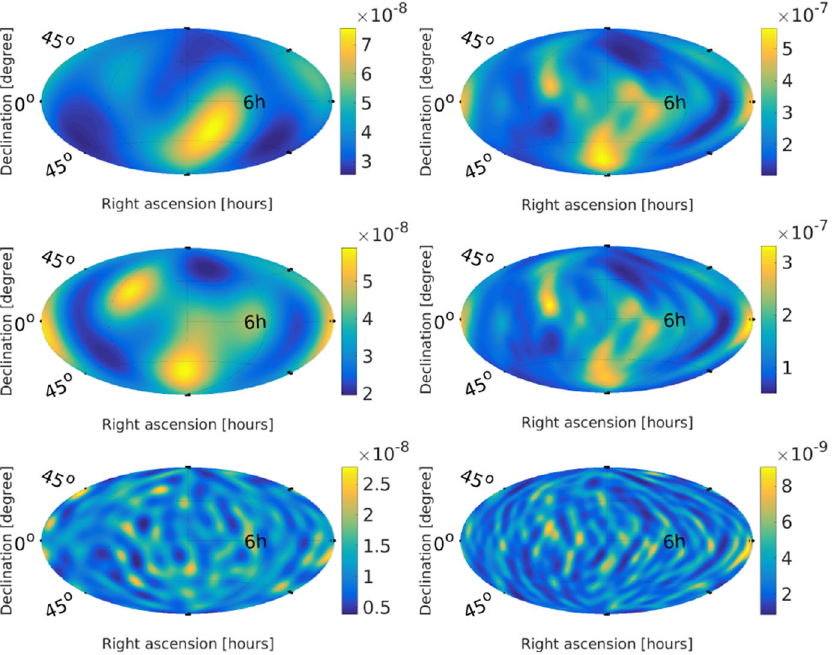
Fig. 85 90% confidence-level upper-limit maps on gravitational-wave power for anisotropic backgrounds having spectral indices β = 0, 2/3, and 3 ( first, second, and third row , respectively). The data analyzed were from advanced LIGO’s first observational run O1 (Abbott et al. 2016a). Left column UL maps on the fractional energy density Ω β ( ˆ n ) expressed in units of sr − 1 , constructed using the spherical harmonic decompositionmethodoutto l max = 3,4,and16. Rightcolumn ULmapsontheenergyflux F β, ˆ n in units of ergcm − 2 s − 1 Hz − 1 , constructed using the radiometer method, which assumes a point-source signal model. Figure adapted from Abbott et al.